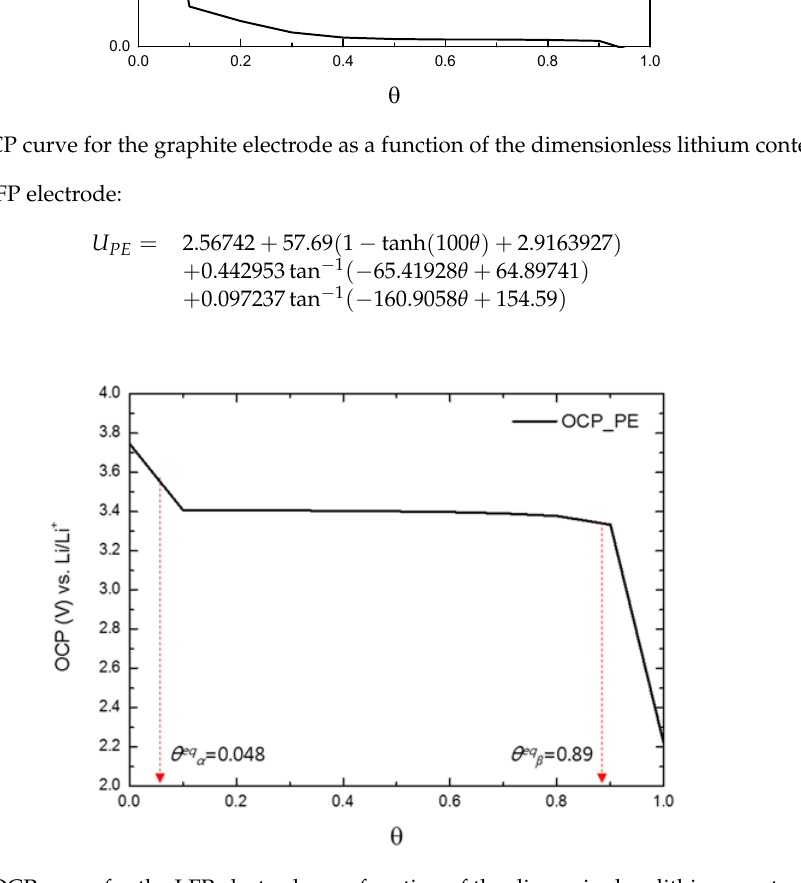
Figure A2. OCP curve for the LFP electrode as a function of the dimensionless lithium content, θ . The OCP curve for the LFP material in Figure A2 consists of two descending curves representing lithium ion diffusion in the α and β solid solution phases, and one plateau region where the phase transition occurs. While the plateau potential around 3.4 V is fixed in this study, different α and β solution ranges are considered